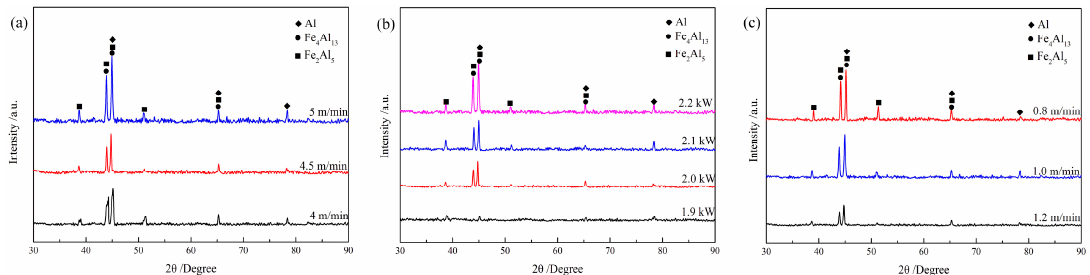
Figure 12. Microstructure of the IMCs layer with different welding speed: ( a ) 0.8 m/min; ( b ) 1.0 m/min; ( c ) 1.2 m/min.